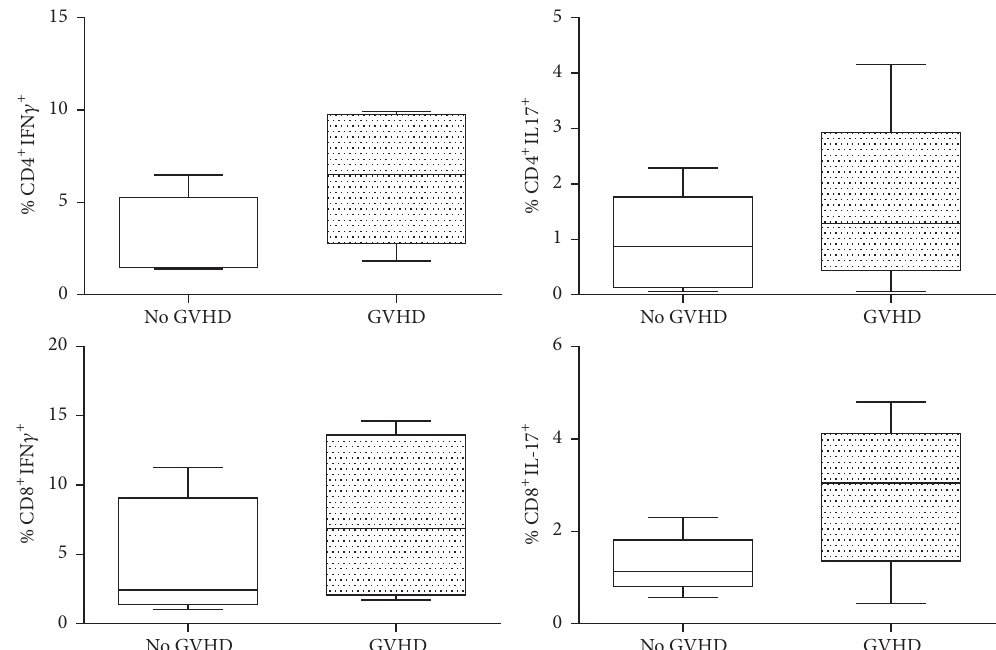
Figure 4: Correlation of patients with GVHD and without GVHD and percentage of type 1 and type 17 cells in the corresponding donor. No significant differences are seen, but a correlation ( 𝑝 = 0.06 ) exists, which indicates that patients who develop GVHD are patients who received a higher percentage of Th1 cells (CD4 + IFN 𝛾 +